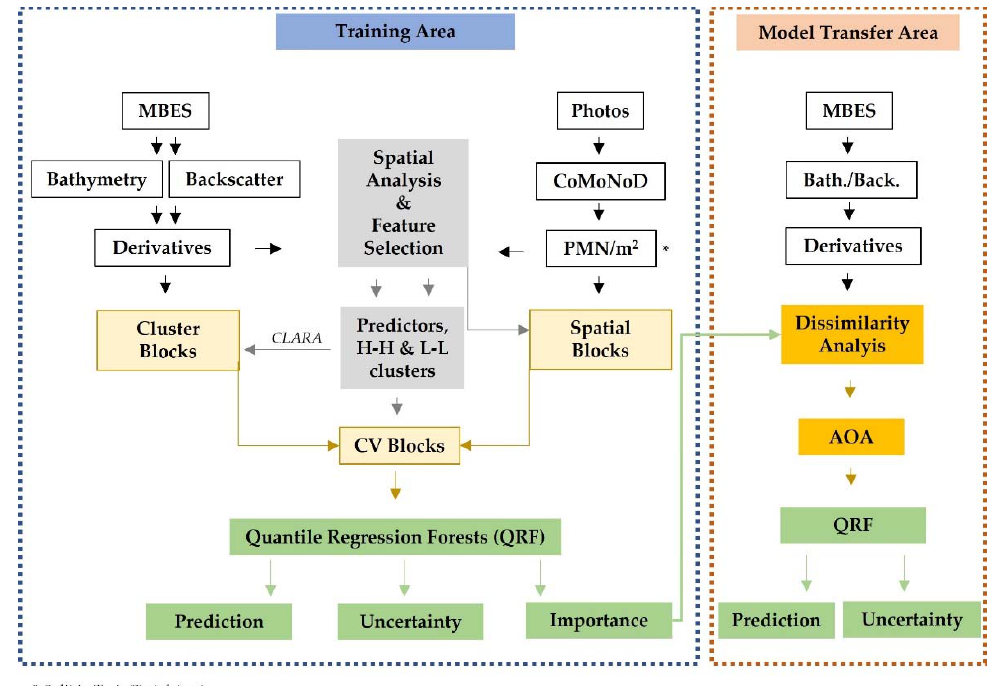
Figure 2. The general analyses and modeling workflow with its different processing steps. For de- scription, see text.